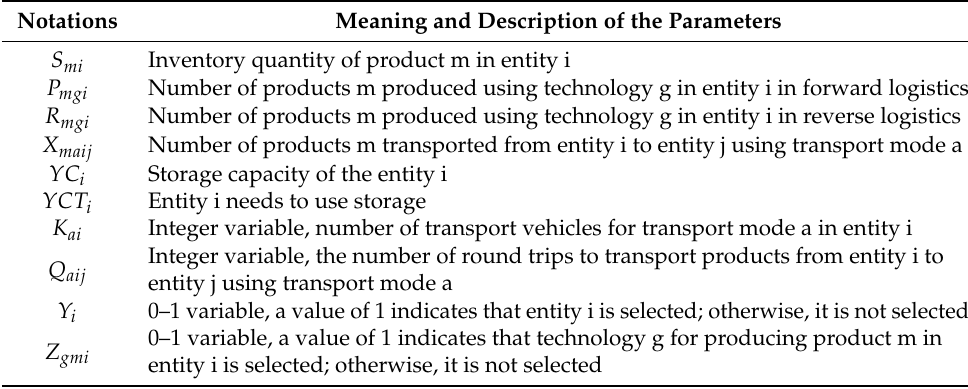
Table 3. Decision variables of mathematical